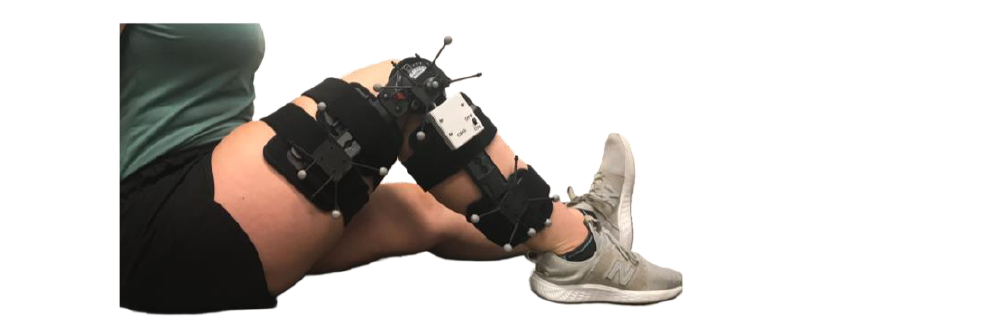
Figure 2. Instrumented knee brace with rigid body bases and reflective markers attached at the thigh, knee, and shank.